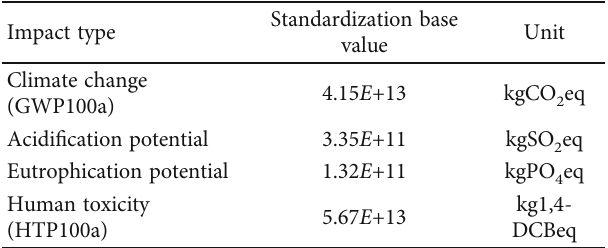
Table 28: Normalization reference value of CML 2001.